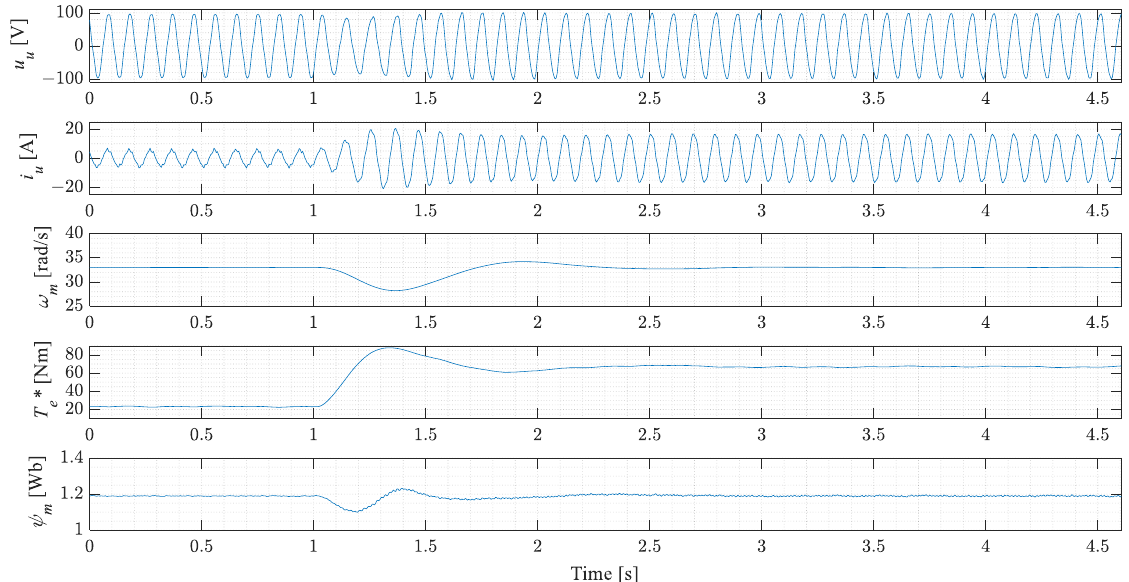
Figure 13. Experimental results of the cycloconverter drive during load torque change at 35% of the rated machine speed.